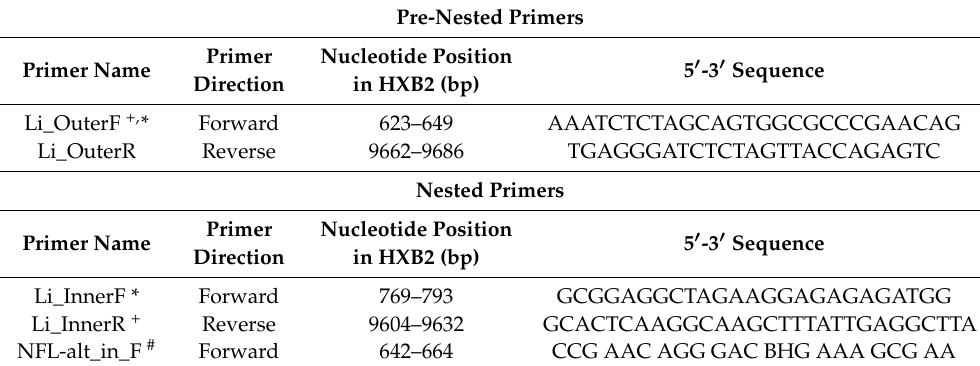
Table 2. Near full-length single-genome amplification